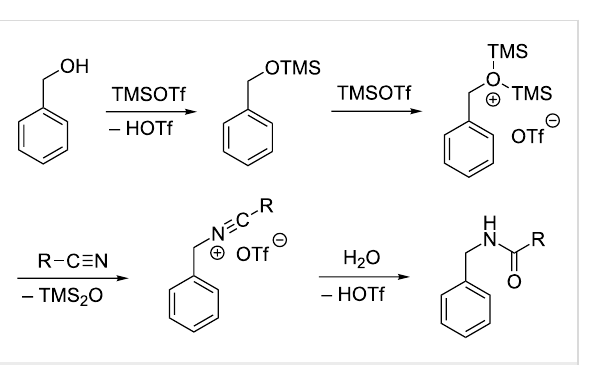
Scheme 7: Proposed mechanism of the trimethylsilyl triflate-promoted Ritter reaction.